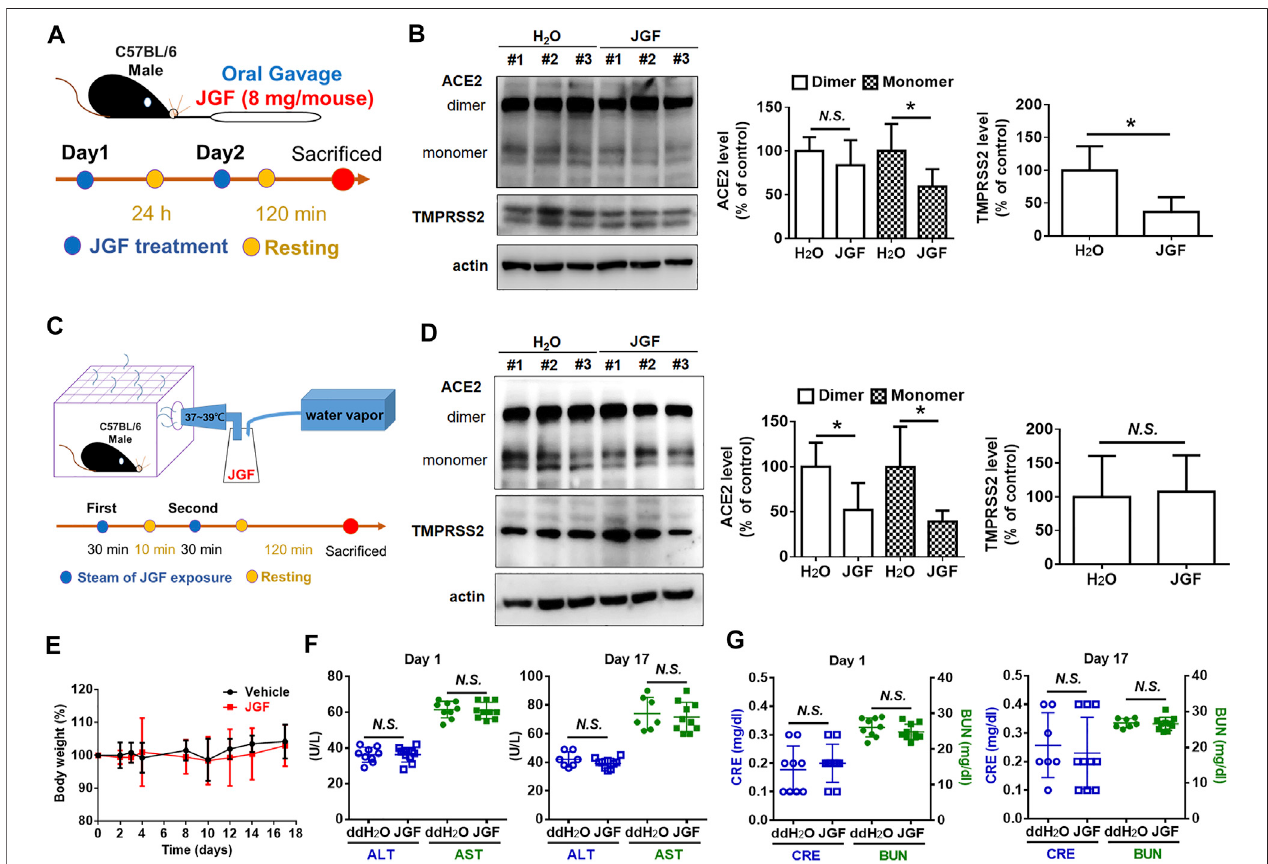
FIGURE 5 | JGF reduces ACE2 and TMPRSS2 on lung tissues of mouse model. (A) Scheme for mouse receiving JGF via oral gavage. (B) ACE2 and TMPRSS2 levelsinlungtissuesofmicereceivingJGFviaoralgavage. (C) SchemeformousereceivingJGFviasteamspraymethod. (D) ACE2andTMPRSS2levelsinlungtissueof micereceivingJGFviasteamspray. (E) Thebodyweightchanges(%)formicereceivingJGFviaoralgavageeveryotherday. (F,G) TheASTandALT(hepaticfunction; F ) as well as BUN and Creatinine (renal function; G ) of mice sera were analyzed on Day 1 and Day 17.